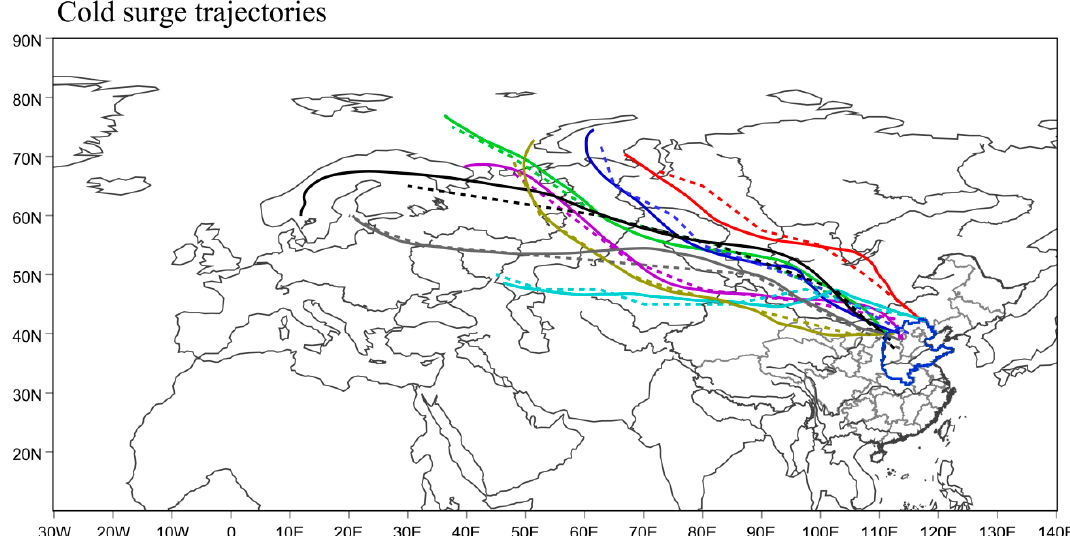
Figure 2. Comparison between surface temperature drop centrode paths (dashed lines) and cold air paths tracked with the Hybrid Single-Particle Lagrangian Integrated Trajectory (HYSPLIT) model (solid lines) every 24 h in the preceding six days of eight cold surges that occurred in North China.